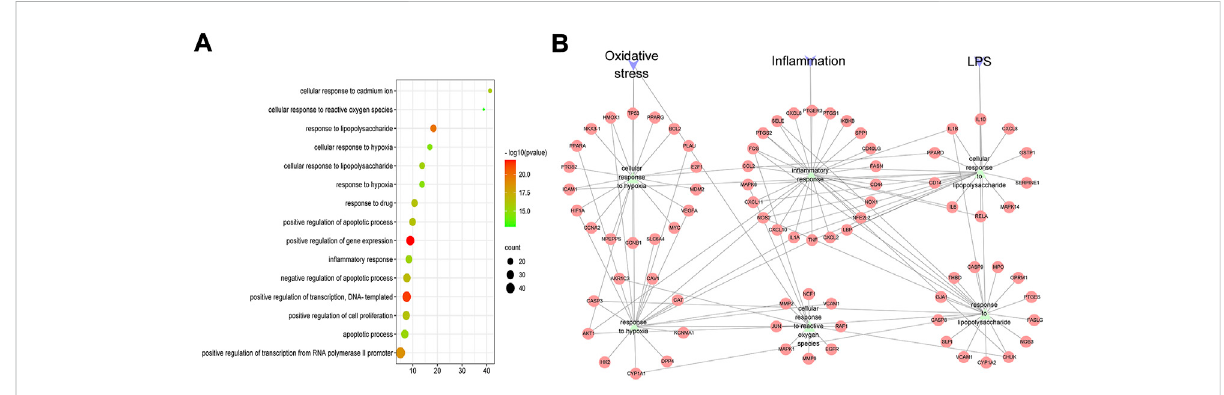
FIGURE 2 GO-BPanalysisofHZJDD-UCcommontargets. (A) Bubblechartofthe fi rst15biologicalprocesses. (B) PPInetworkof “ in fl ammation,oxidative stress, and lipopolysaccharide ” biological process and HZJDD-UC common